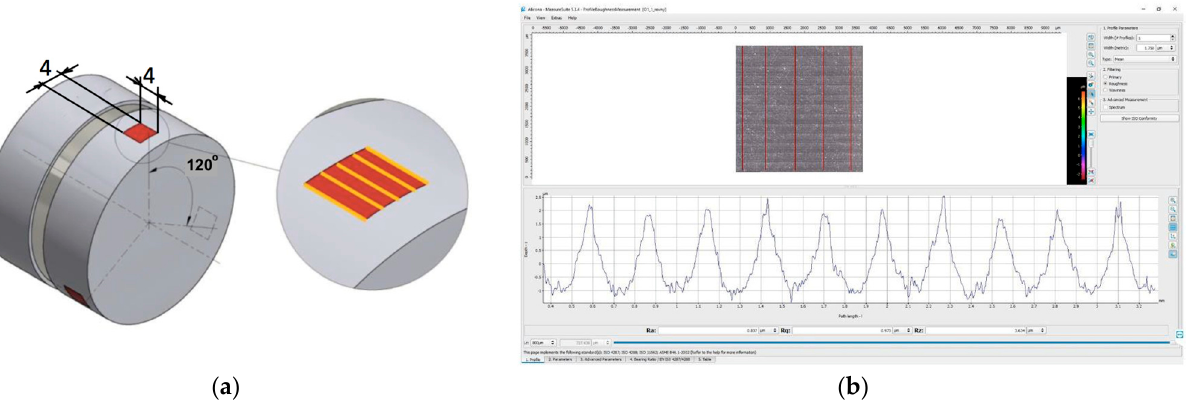
Figure 3. Measurement of the profile parameters: ( a ) scanned area on the bearing surface; ( b ) example of the screen during profile measurement, where red lines correspond with analyzed profiles on the scanned area.